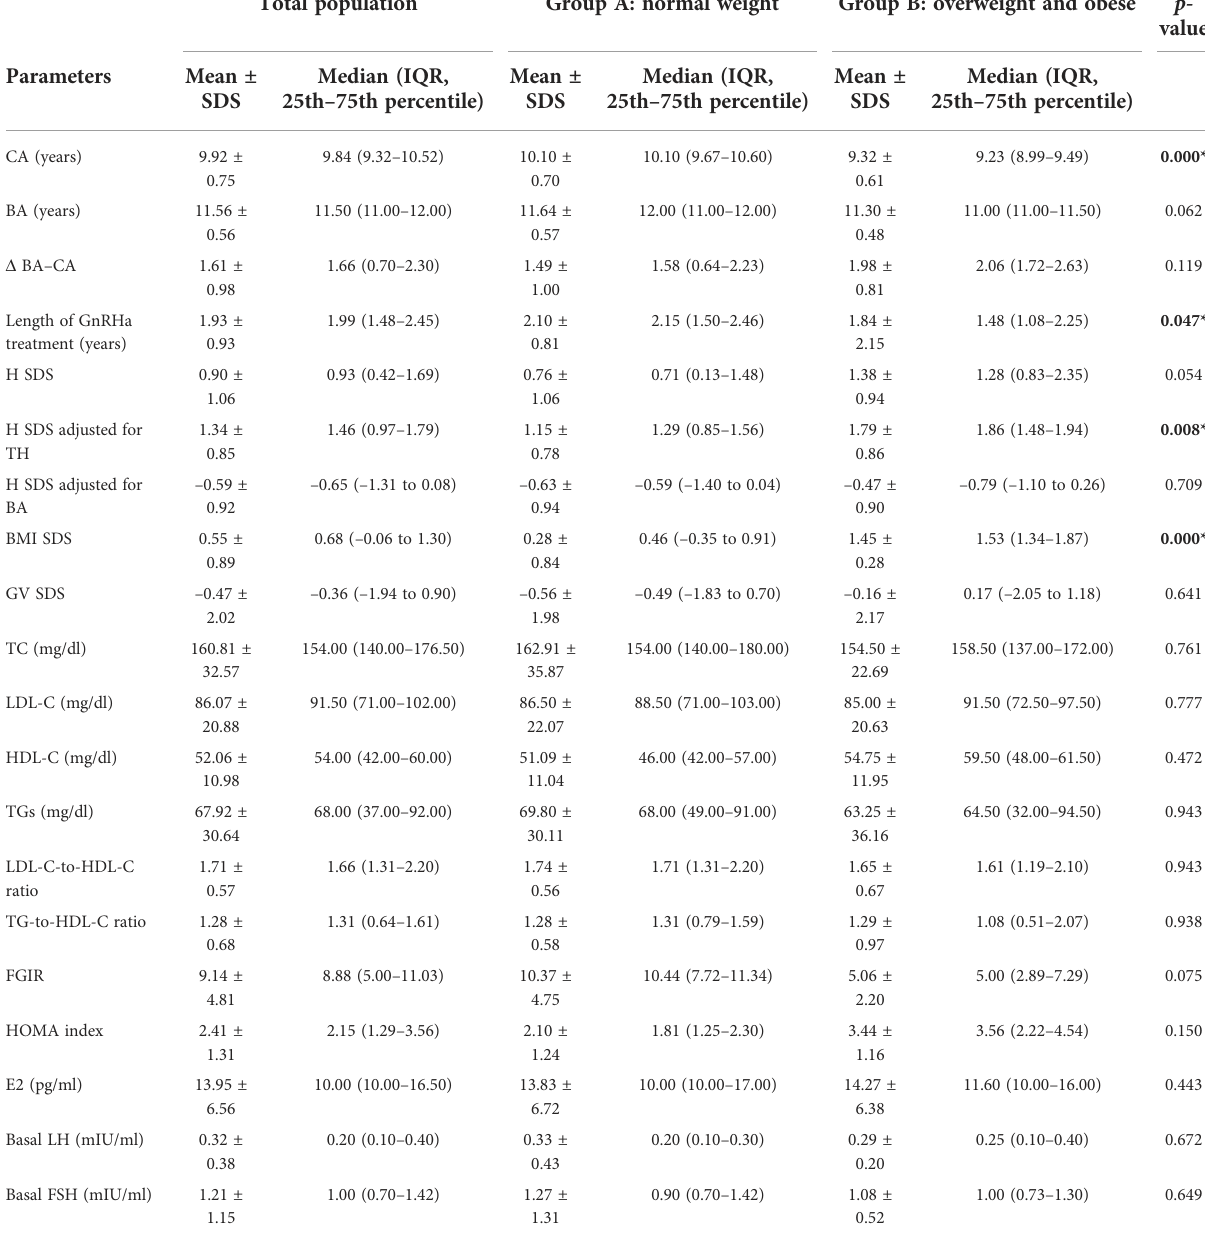
TABLE 2 Anthropometric and biochemical features in the total population, group A and group B at the end of gonadotropin-releasing hormone analog (GnRHa) treatment (T2). Total population Group A: normal weight Group B: overweight and obese p -